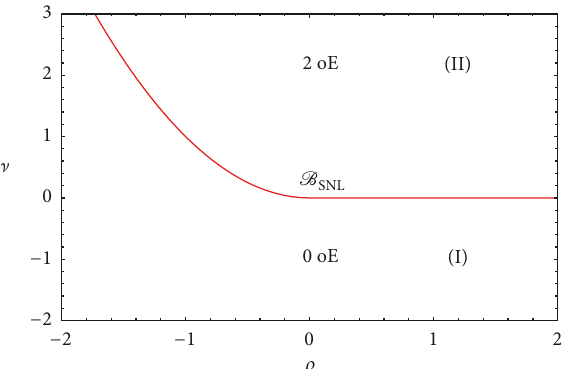
Figure 7: Bifurcation diagram of the regularization of system (20a), (20b), (20c), and (20d) in (𝜌, ] ) plane when 𝛿 = 𝜎 = −1 .